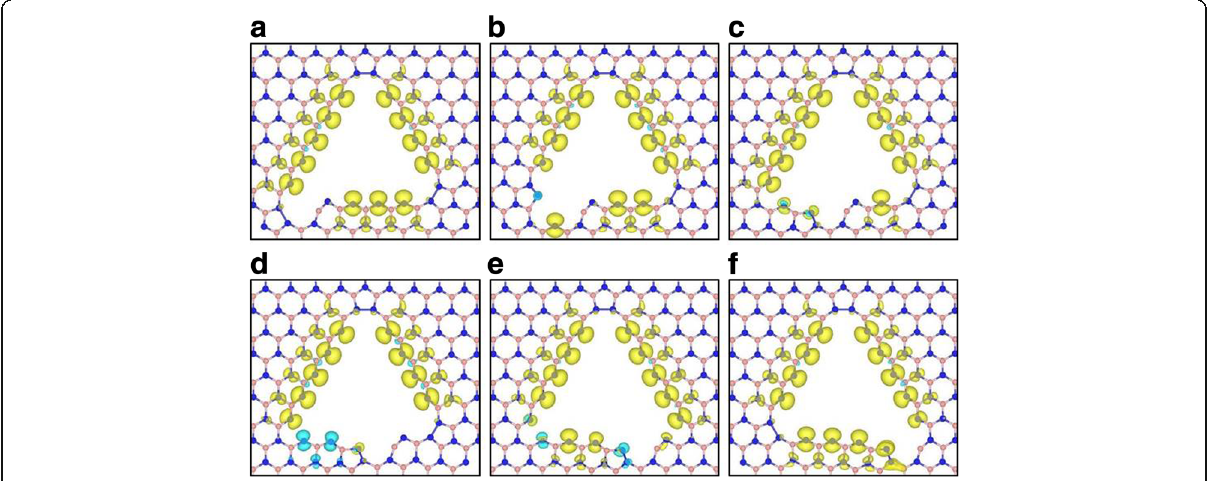
Fig. 3 The spin density ( ρ spin up - ρ spin down ) distributions for the optimized structures of BN-pair missing. Yellow and light blue isosurfaces indicate the positive and negative values of spin densities,